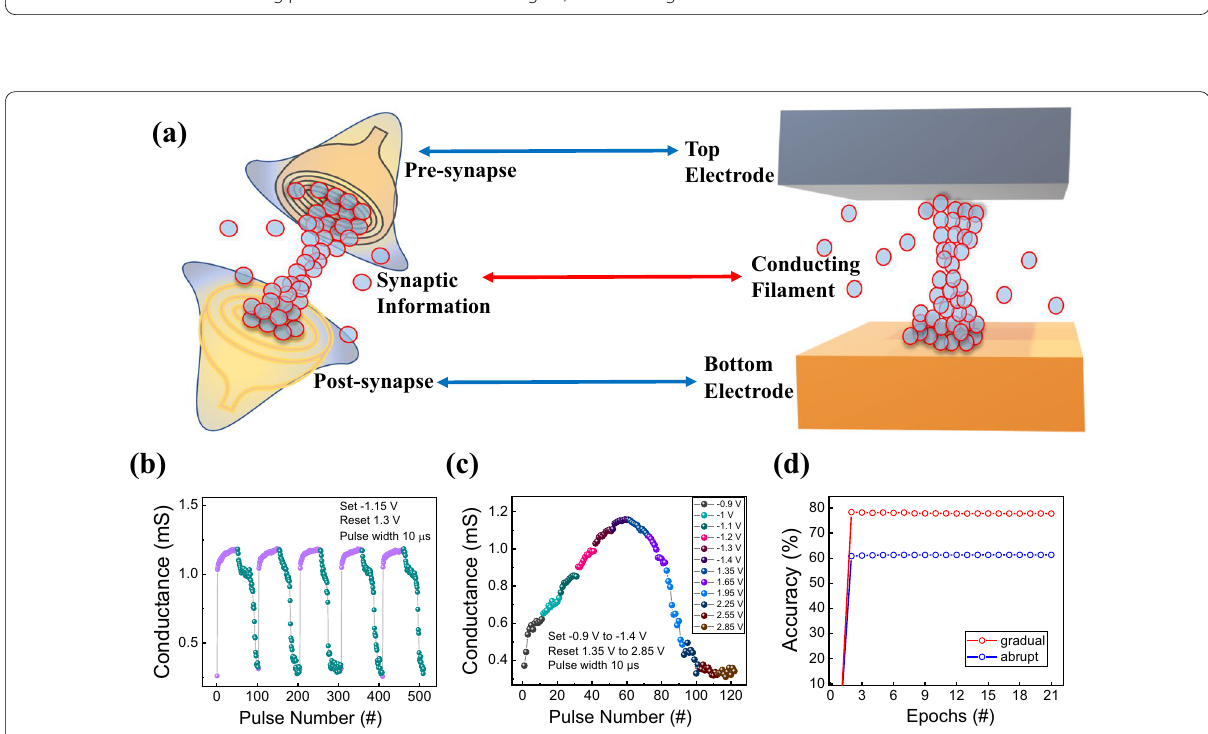
Fig. 6 a Schematic illustration of similarity between human synaptic neural structure and RRAM device structure. Potentiation and depression characteristics: b consecutive same voltage pulse, c single incremental voltage pulse. d MNIST pattern recognition simulation results of ( b ) and ( c